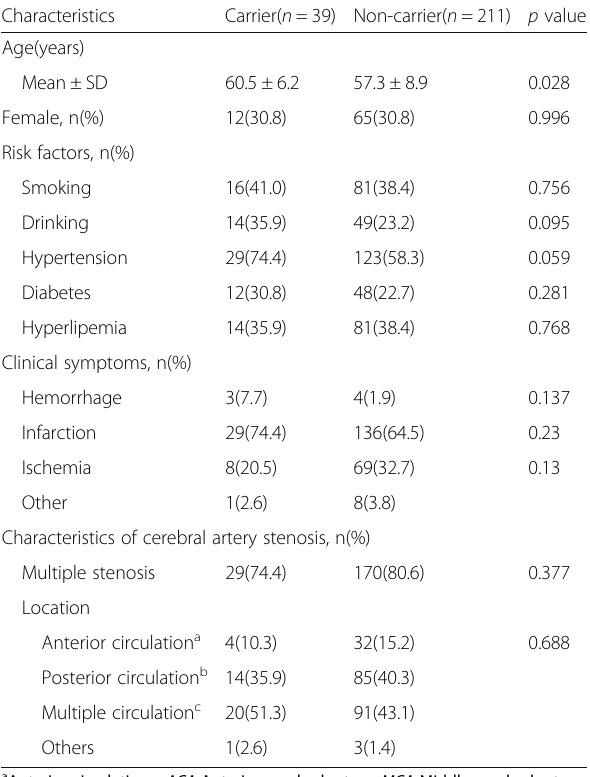
Table 5 Characteristics of RNF213 rare variants carriers and non-carriers